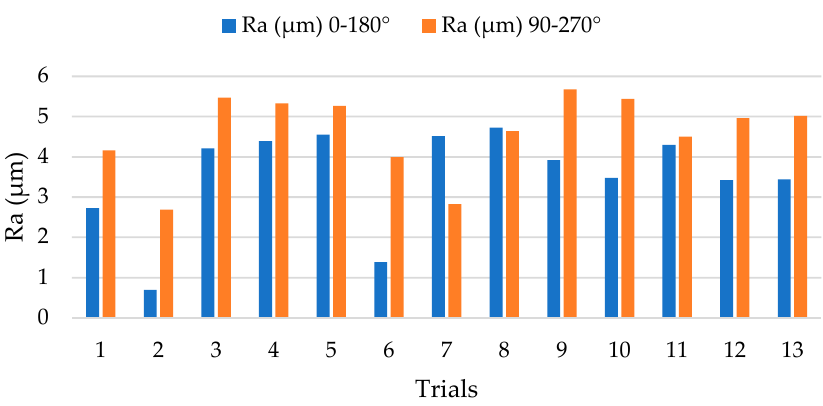
Figure 3. Surface roughness values after EDM drilling tests in two evaluation